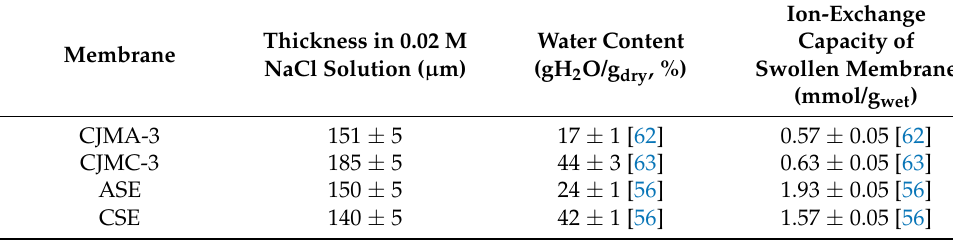
Table 1. Some characteristics of the studied membranes.